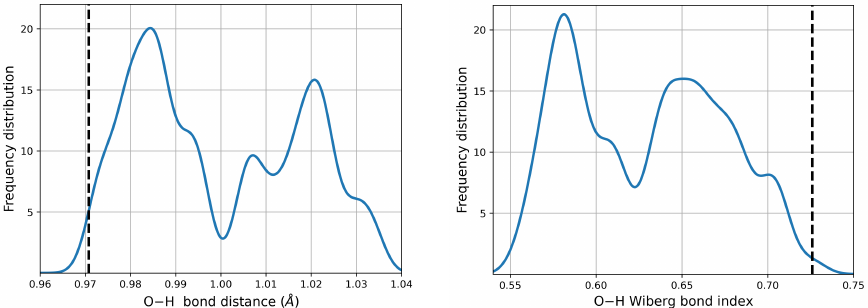
Figure 4. Variation of the O–H bond properties as a consequence of intermolecular interactions. The reference values for the n 2 cysteine monomer are included as vertical dashed